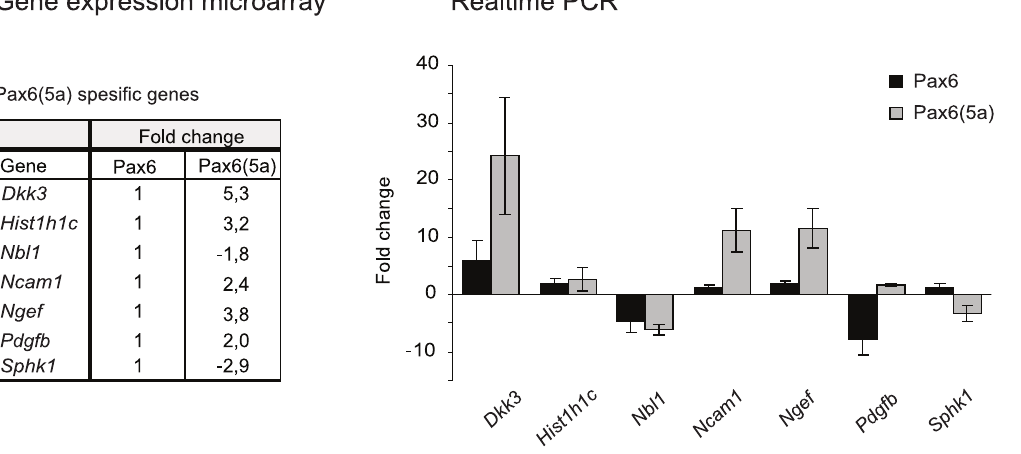
Figure 5. Real time quantitative PCR shows that Dkk3, Ncam1, Ngef and Sphk1 are strongly regulated by Pax6(5a). Primers were designed for some of the genes showing differential expression only in the FlpIn-3T3 Pax6(5a) cell line (Dkk3, Hist1h1c, Nbl1, Ncam1, Ngef, Pdgfb, Sphk1). Real time quantitative PCR was performed as described in Fig. 4. The fold change values obtained for the same genes in the Illumina gene expression microarray are given in the table to the left of the graph for